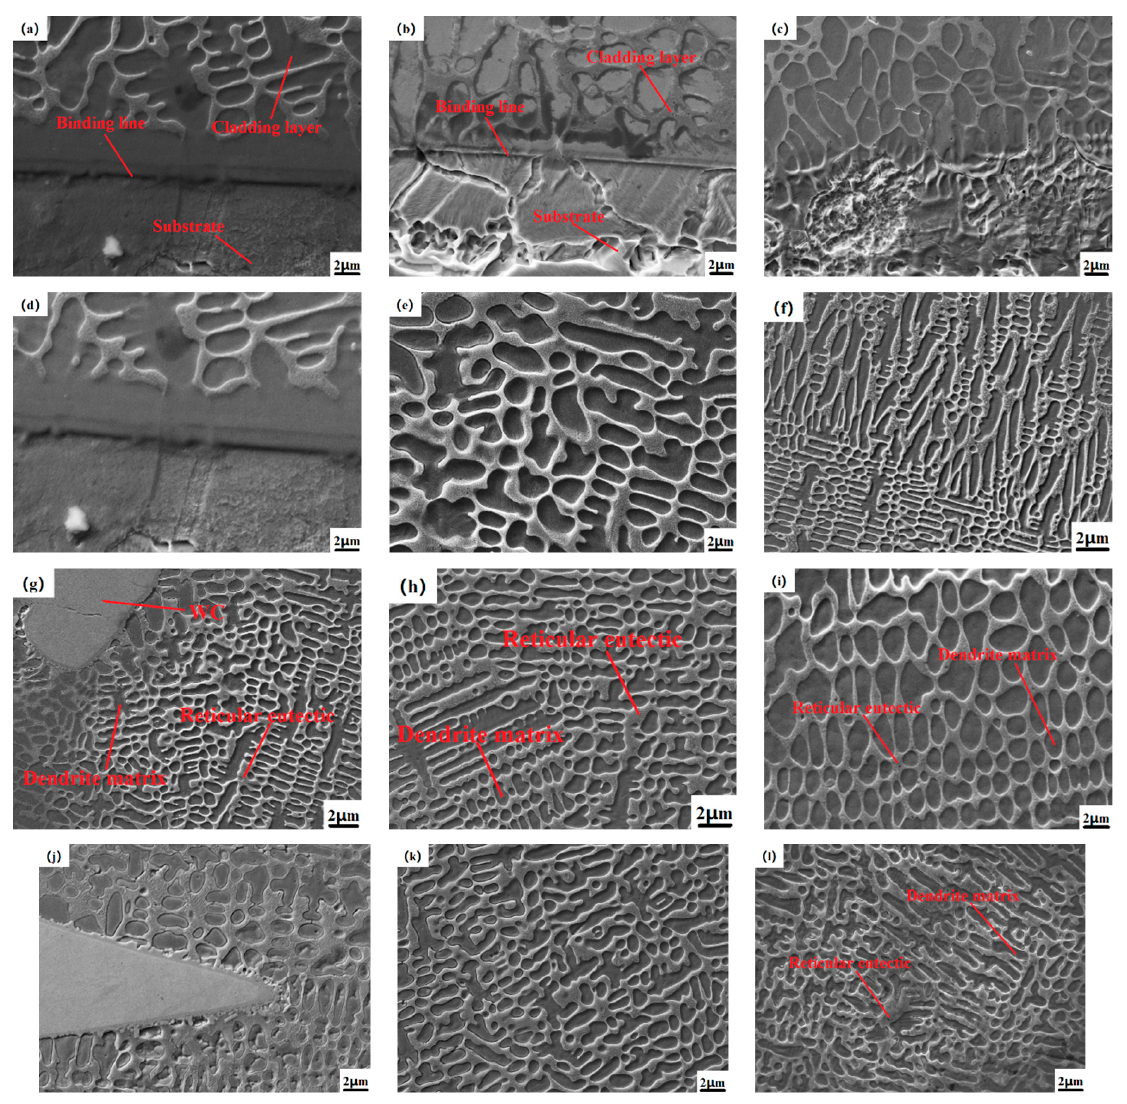
Figure 4. SEM image of Co-Cr-WC composite cladding layer. ( a , e , i ) Co-Cr; ( b , f , j ) Co-Cr-10%WC; ( c , g , k ) Co-Cr-30%WC; ( d , h , l ) Co-Cr-40%WC.